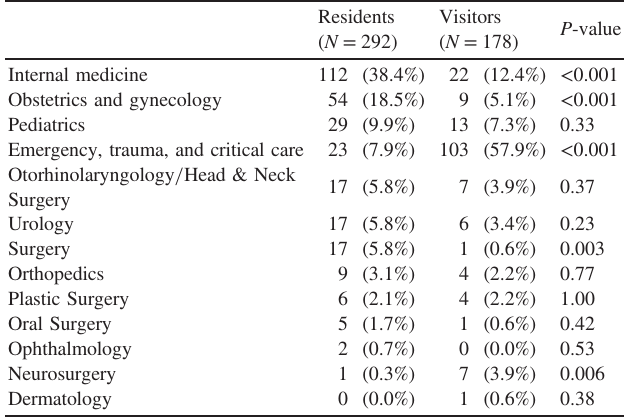
Table 3. First visited department of resident and visitor foreign